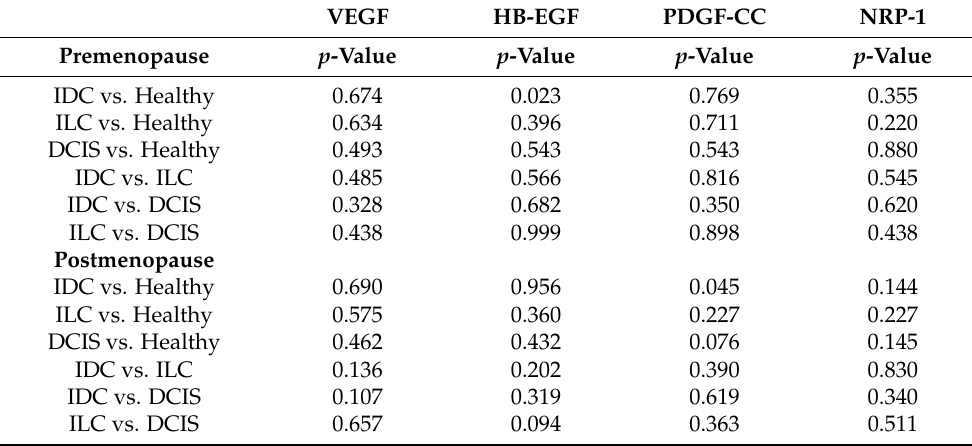
Table 6. p values were determined in order to investigate the differences in protein levels between breast cancer histological types and control group as well as among the different histological types when considering the menopausal status of the examined